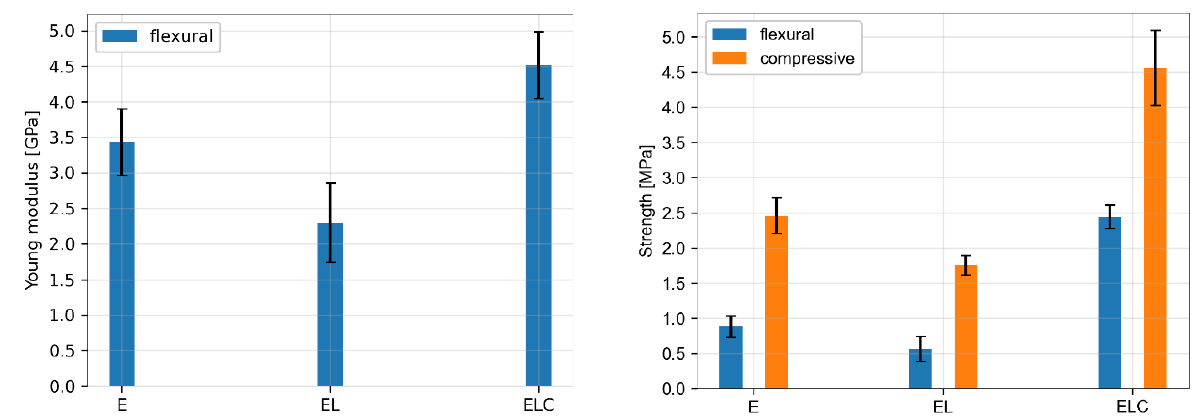
Figure 37. Mechanical strengths of the hardened mortars ( left ) and Young’s modulus in bending ( right ).